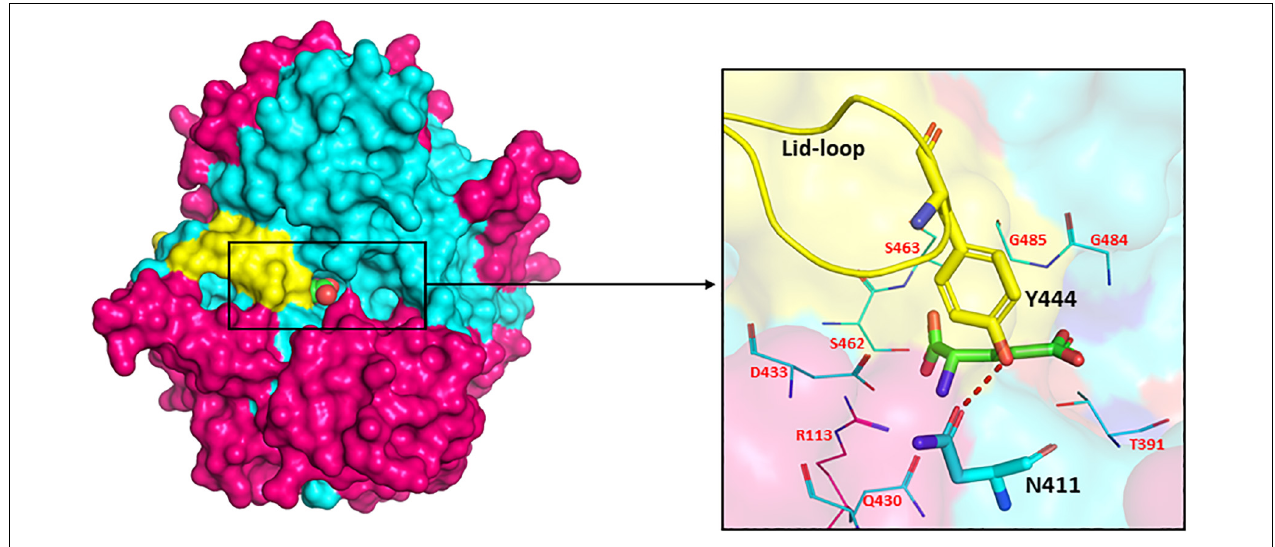
FIGURE 6 | Surface drawing of Escherichia coli gamma-glutamyl transpeptidase (EcGGT) (PDB ID: 2DBX) showing the arrangement of lid-loop around substrate-binding pocket. Pink color highlights large subunit, cyan color highlights small subunit, and L-Glu is represented as a sphere in the surface drawing. Hydrogen bonding between residues Asn411 and Tyr444 is shown by the red dotted line. The active site residues surrounding the bound substrate L-Glu are pictorially shown as lines. The structures are prepared using PyMOL2